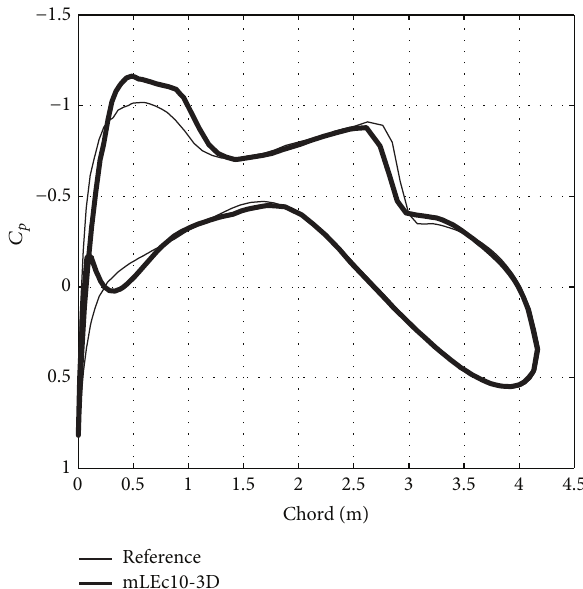
Figure 14: Comparison between reference and morphing shape 3D results in terms of 𝐶 𝑝 chordwise distribution of the wing section placed at 4.7 m along the wing